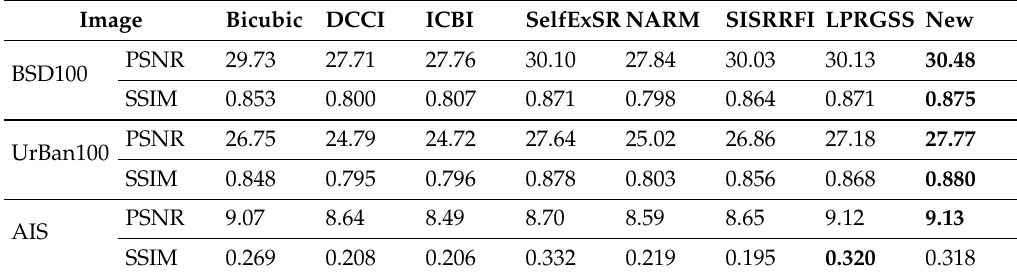
Table 2. Average PSNR and SSIM values for 8 methods for BSD100, Urban100, and aliasing image set